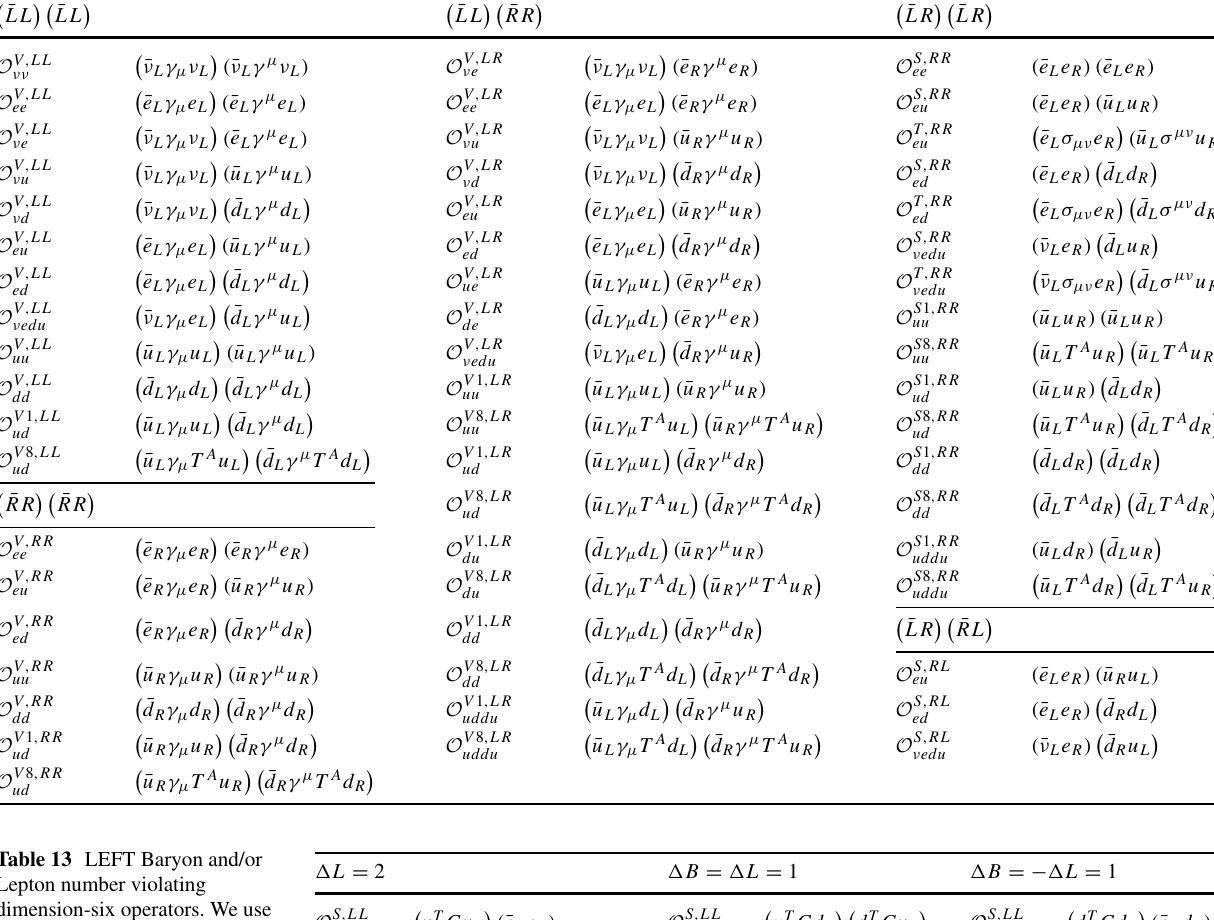
Table 12 LEFT Baryon and Lepton number conserving dimension-six operators (cid:12) (cid:12)(cid:11) (cid:11) ¯ LL ¯ LL